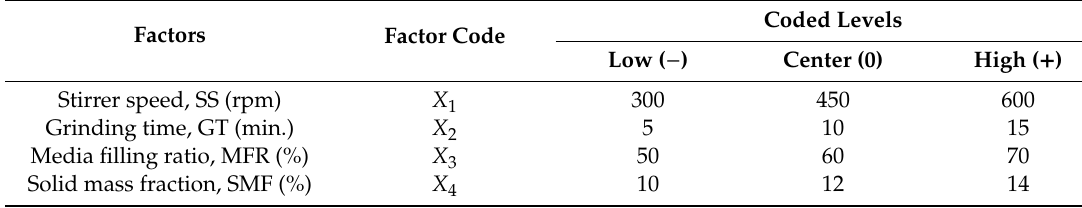
Table 2. Experimental factors and their corresponding